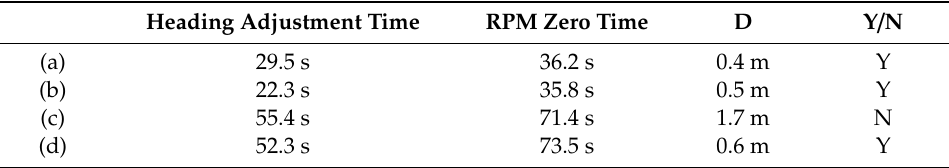
Table 5. Analysis of the results of simulation of ship automatic berthing.